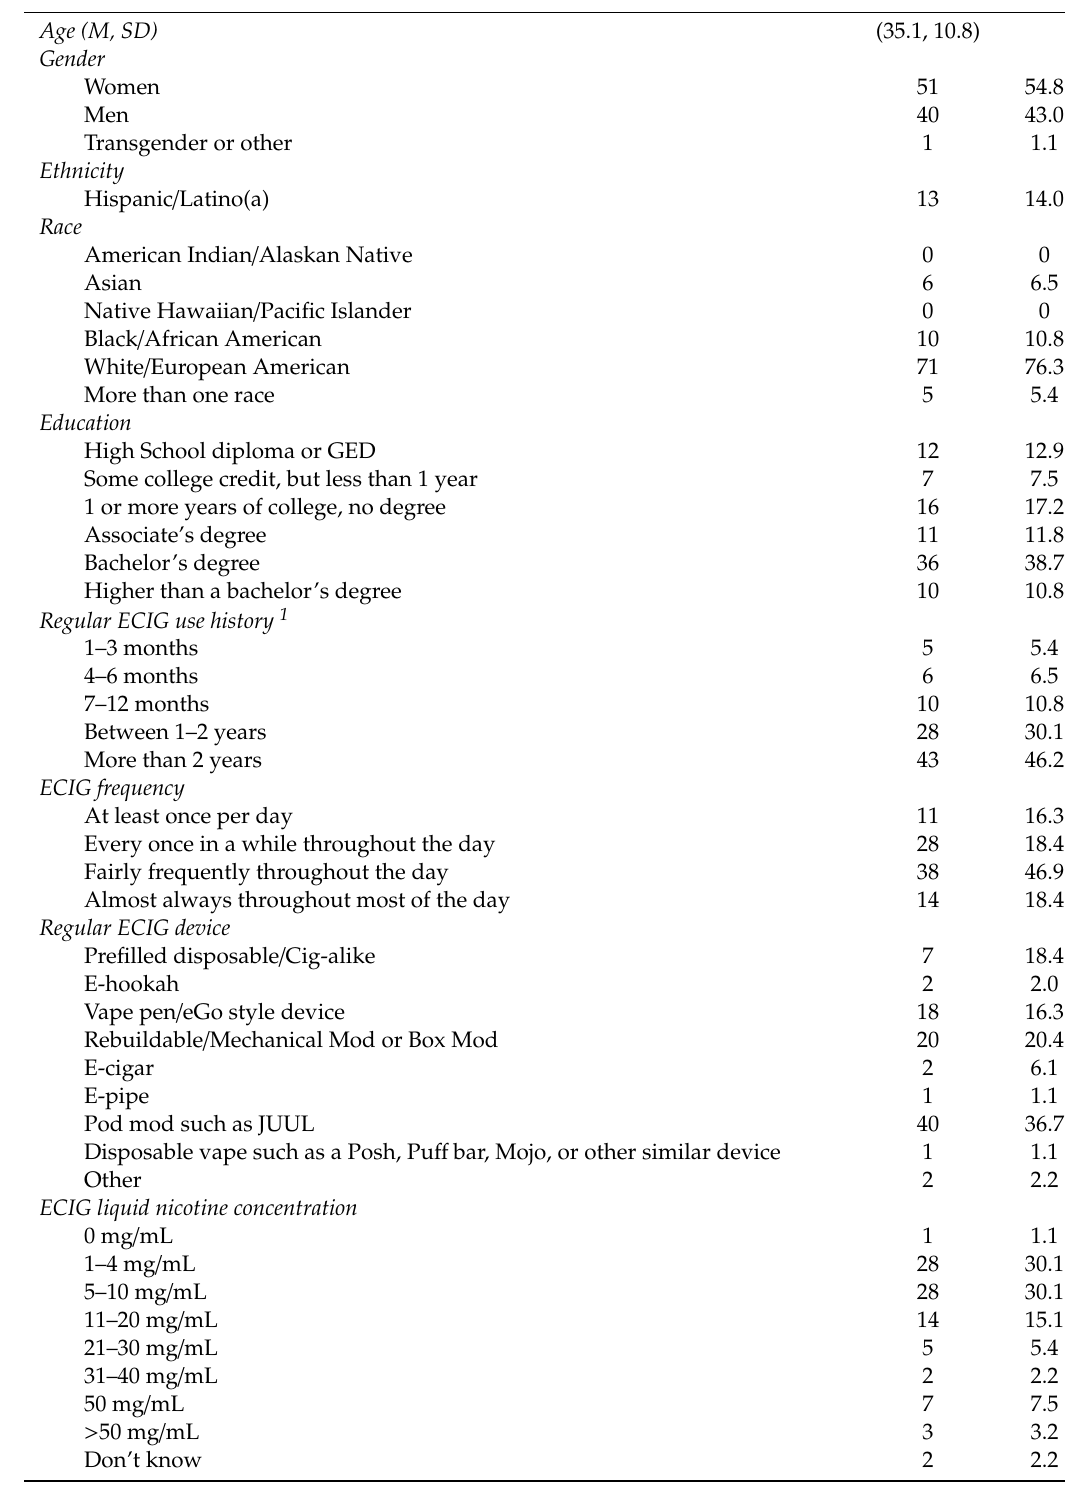
Table 1. Sample demographics and ECIG / tobacco use